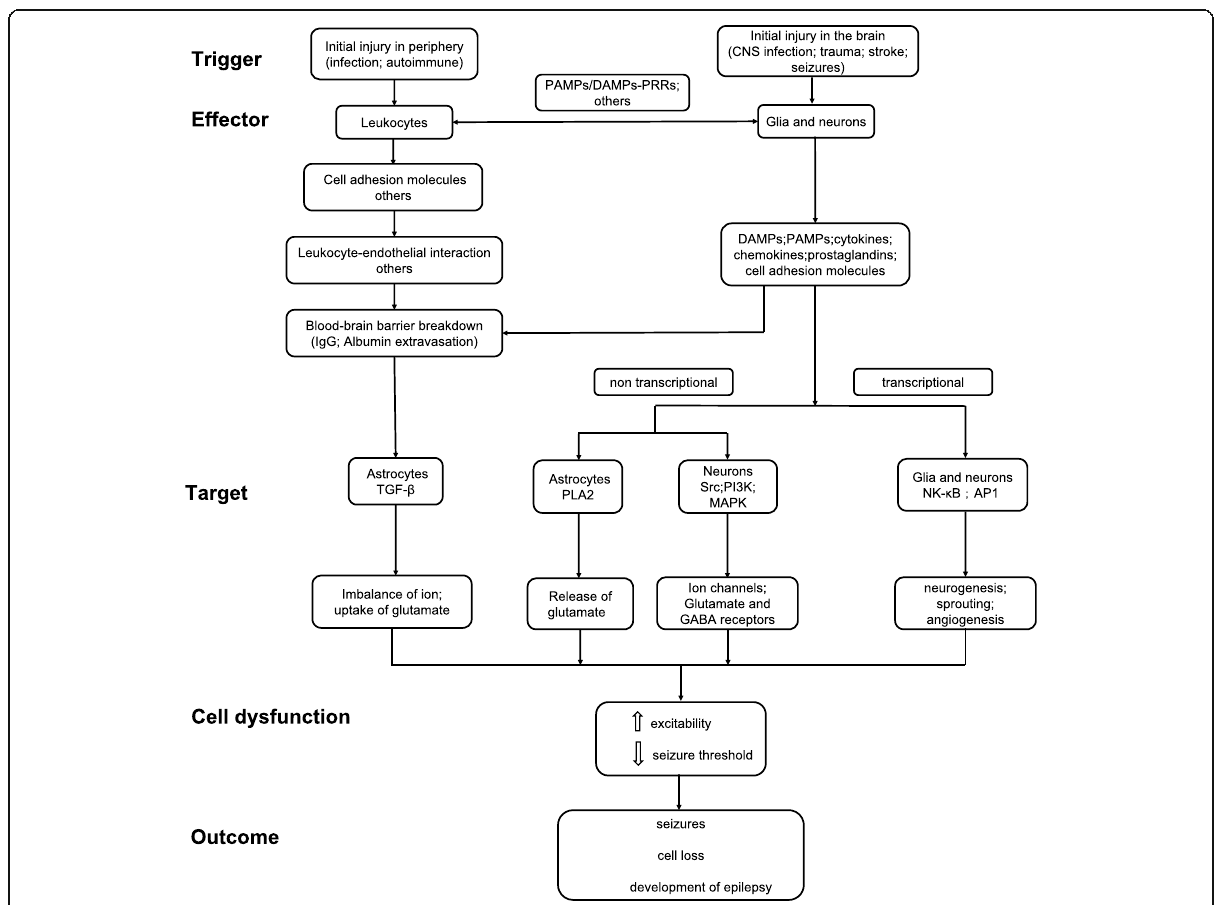
Fig. 1 Schematic of the involvement of inflammatory cascades in epileptogenesis. PAMPs, pathogen-associated molecular patterns; DAMPs: damage-associated molecular pattern molecules; PRRs: pattern recognition receptors; TGF- β : transforming growth factor β ; PLA2: phospholipase A2; PI3K: phosphatidyl inositol-3 kinase; MAPK: mitogen-activated protein kinase; NK- κ B: nuclear factor kappa-B; AP1: activator protein-1; GABA: γ -aminobutyric